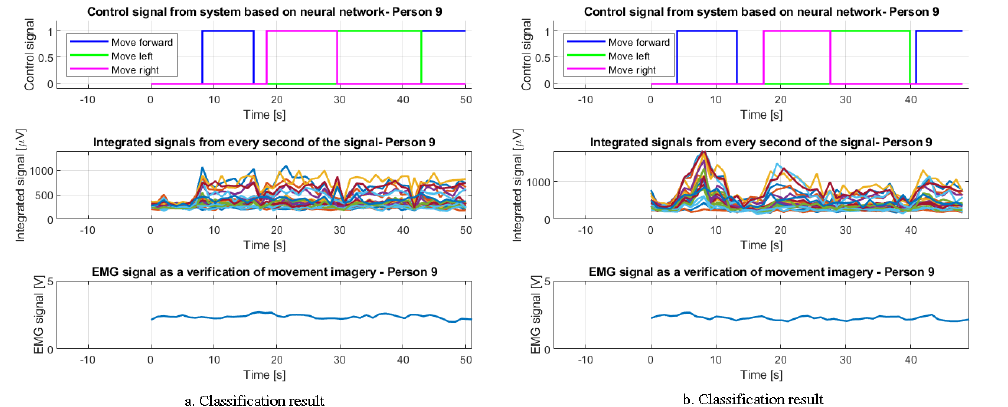
Figure 26. Observation of the signal classification and verification results—Person